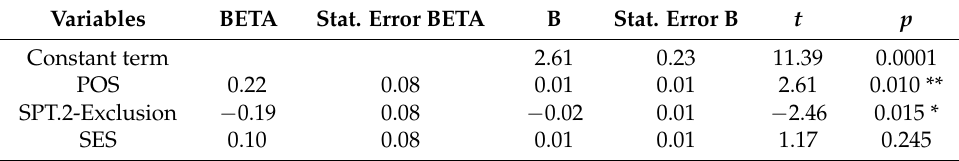
Table 7. Determinants of the ‘support currently received’ variable (SCR). Variables